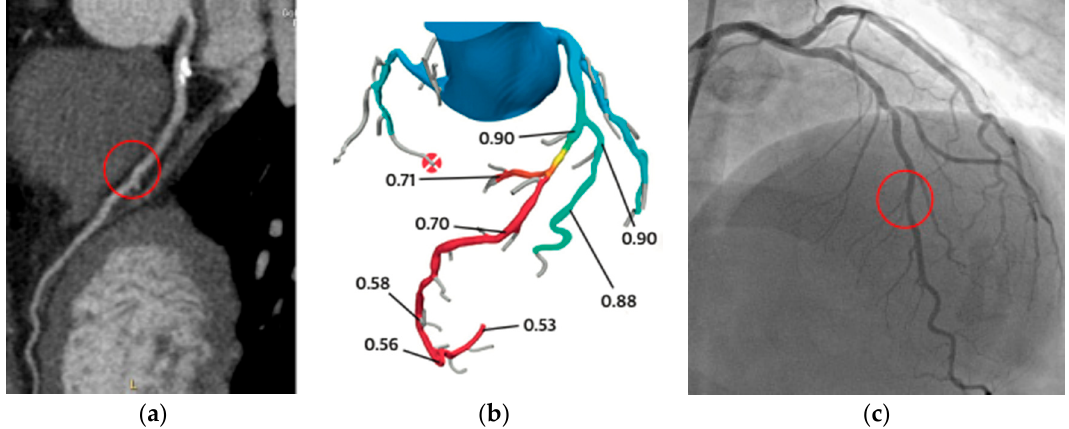
Figure 3. S.M. 54 years-old, male; dyslipidaemia, smoker, PAD; breath shortness; CCTA ( a ): moderate mid-LAD stenosis (see also Figure 2); FFR-CT was performed ( b ): pressure drop after diagonal branch; ICA ( c ): significant tandem-stenosis of LAD (left anterior descending artery). CCTA: coronary computed tomography angiography; LAD: left anterior descending artery; FFR-CT: fractional flow reserve derived from coronary computed tomography; ICA: invasive coronary angiography.